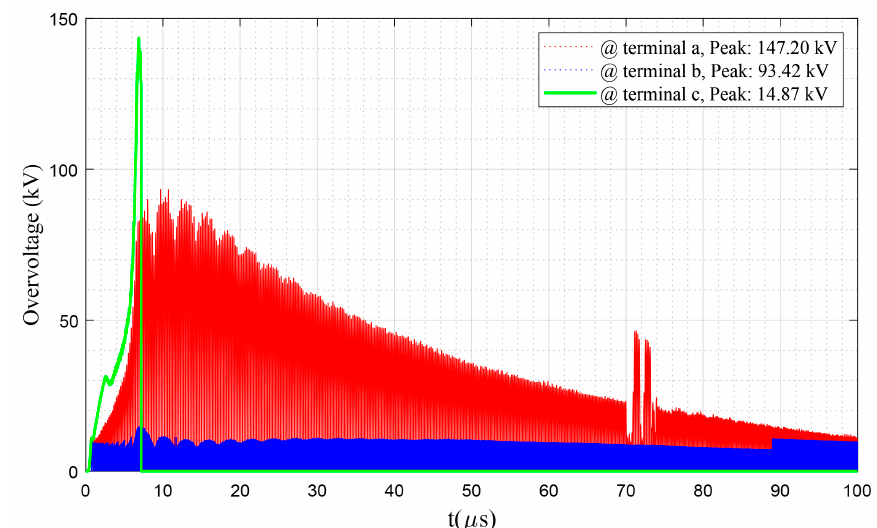
Figure 13. Overvoltage stress at three terminals of transformer mounted at pole #36; Network with dry poles under a lightning strike on pole #35, Case 1.